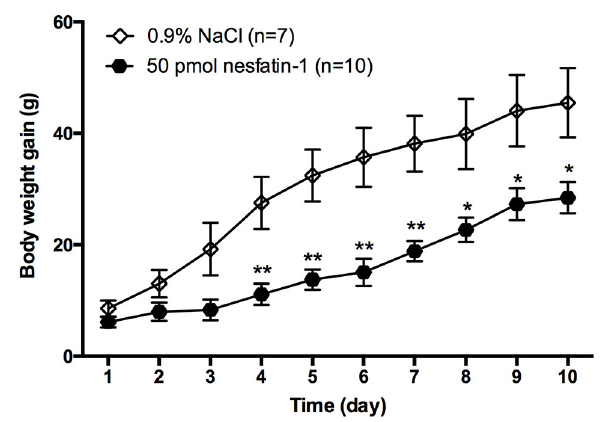
FIGURE 2 | Change in body weight gained after injections of nesfatin-1 for 10 days. Amount of body weight gained (increment from day 0) in rats after nesfatin-1 injections (50 pmol/0.5 µ l daily). Data are mean ± SEM. * P < 0.05, ** P < 0.01 vs. saline vehicle-injected